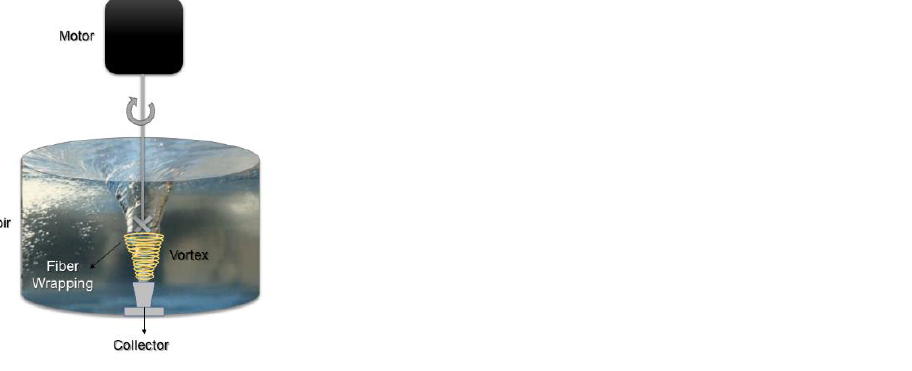
Figure 6. Immersion RJS scheme (modified with permission from [78], Copyright 2017 John Wiley &